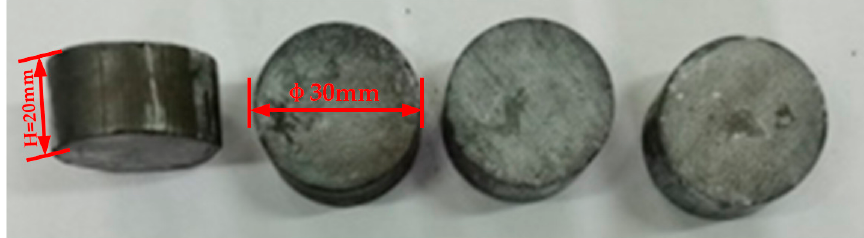
Figure 4. Sintered Zr-6Al-0.1B alloy workpieces.